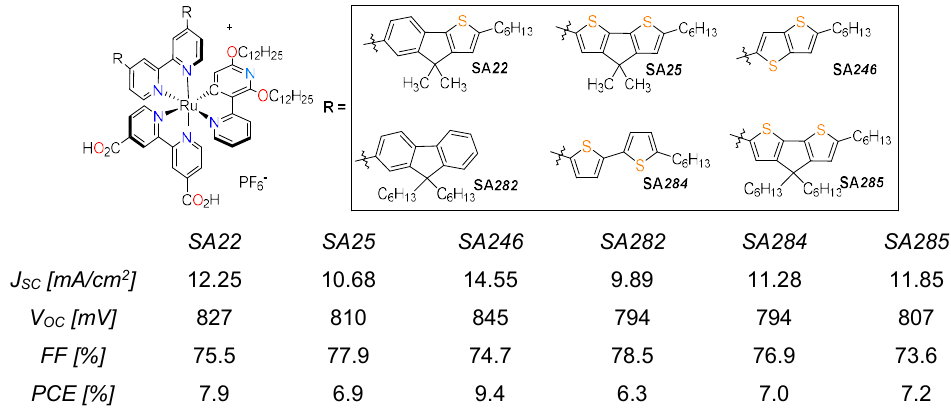
Figure 19. Photovoltaic performance of a series of cyclometalated ruthenium complexes with Co-based electrolyte in DSCs [114].